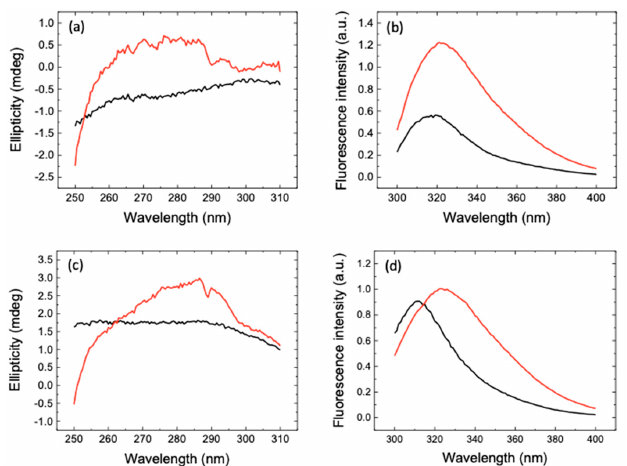
Figure 3. ( a ) Near-UV CD and ( b ) fluorescence emission spectra of the 3CLpro-eugenol complex (black lines) at enzyme and inhibitor concentrations of 10 and 100 µ M, respectively. The addition of individual spectra of 3CLpro and eugenol is also shown (red lines). ( c ) Near-UV CD and ( d ) flu- orescence emission spectra of the 3CLpro-estragole complex (black lines) at enzyme and inhibitor concentrations of 10 and 100 µ M, respectively. The addition of individual spectra of 3CLpro and estragole is also shown (red lines). The non-equivalence between the spectrum of the complex and the addition of the individual spectra of the free species provides direct evidence for the enzyme– inhibitor